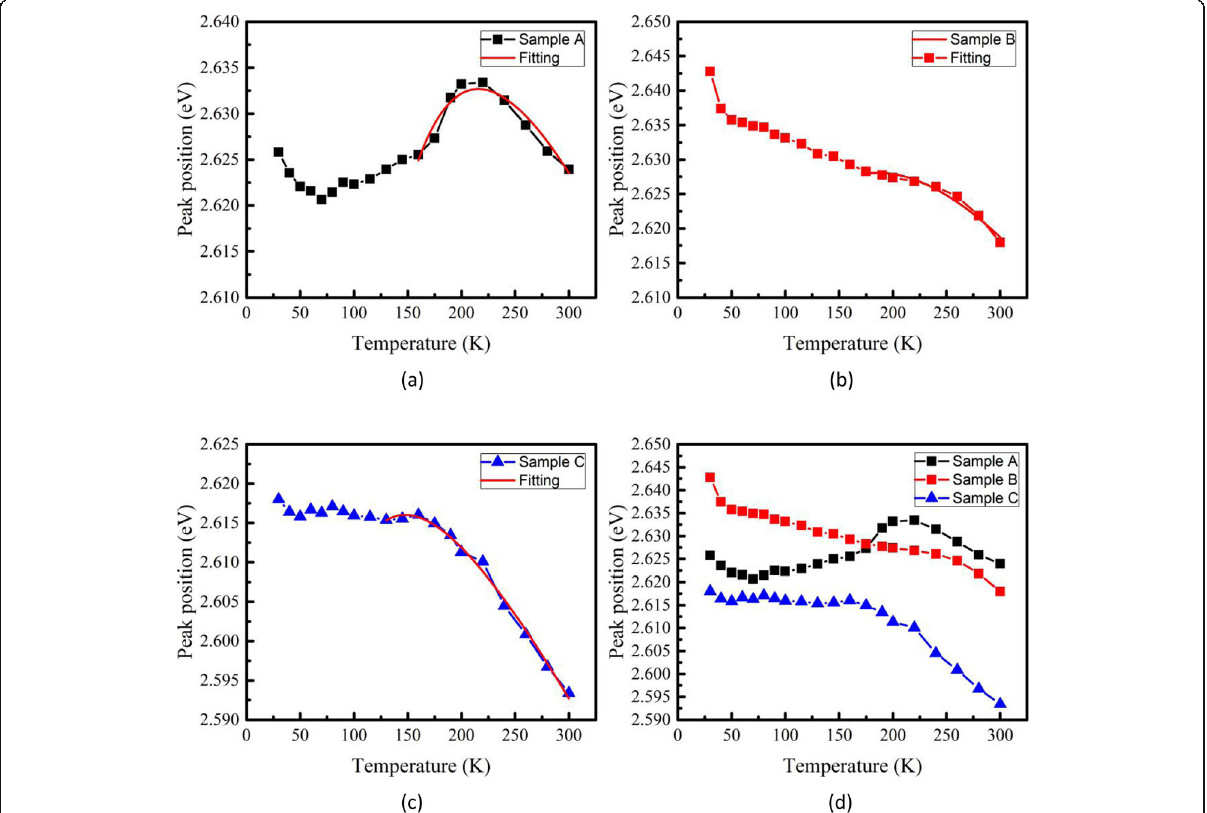
Fig. 5 The red lines in ( a ), ( b ), and ( c ) are fitting curves based on Eq. (1) and the fitting parameter σ is 36.96 meV, 18.89meV, and 23.77 meV for samples A, B, and C, respectively. ( d ) Shows the experimental data of PL peak energy as a function of temperature